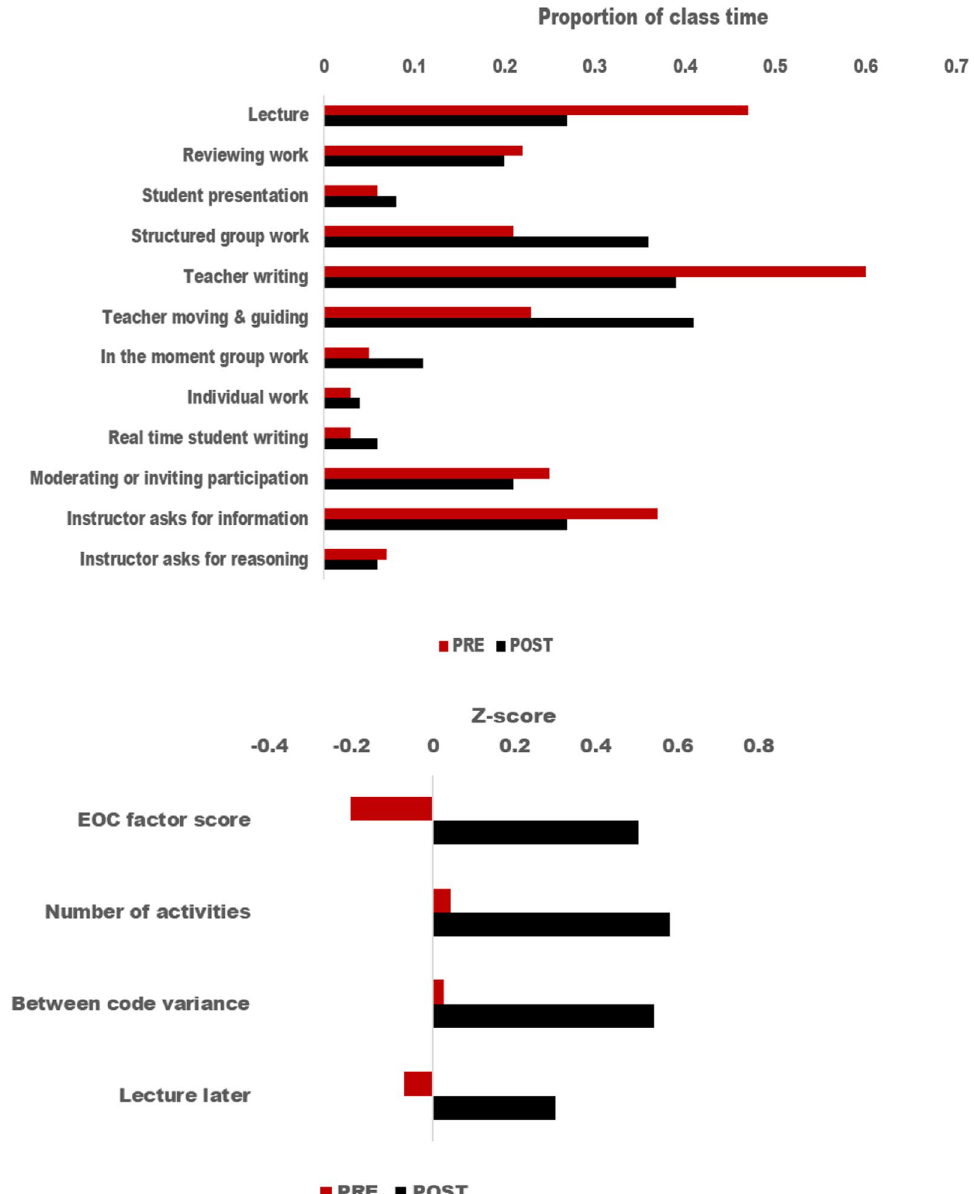
Fig. 6 Pre/post Change for Activity Codes and Global